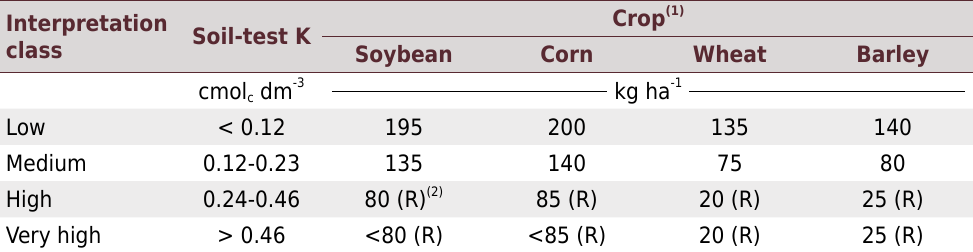
Table 4. K 2 O rates for soybean, corn, wheat, and barley on Oxisols in different interpretation K classes under no-tillage in the central-southern region of Paraná, Brazil